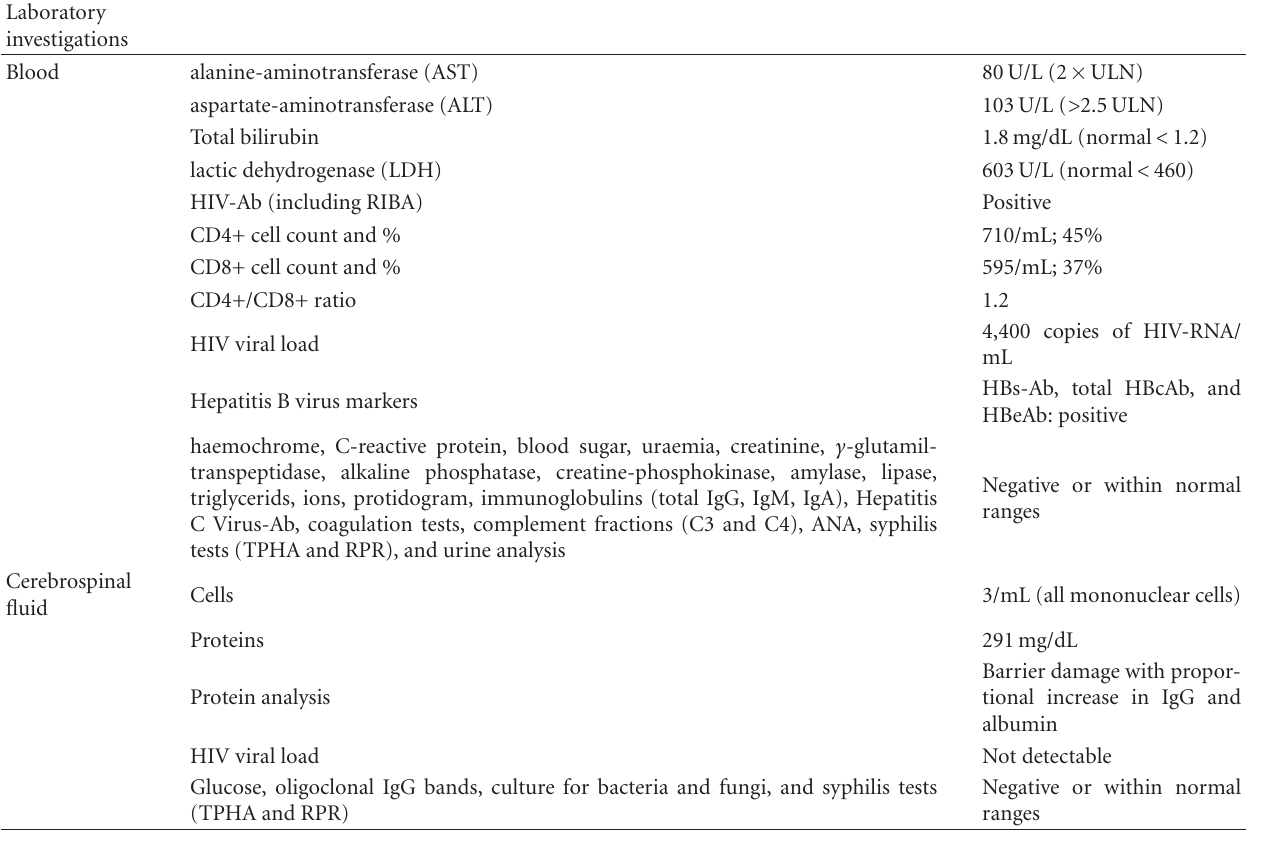
Table 2: Results of diagnostic investigations during